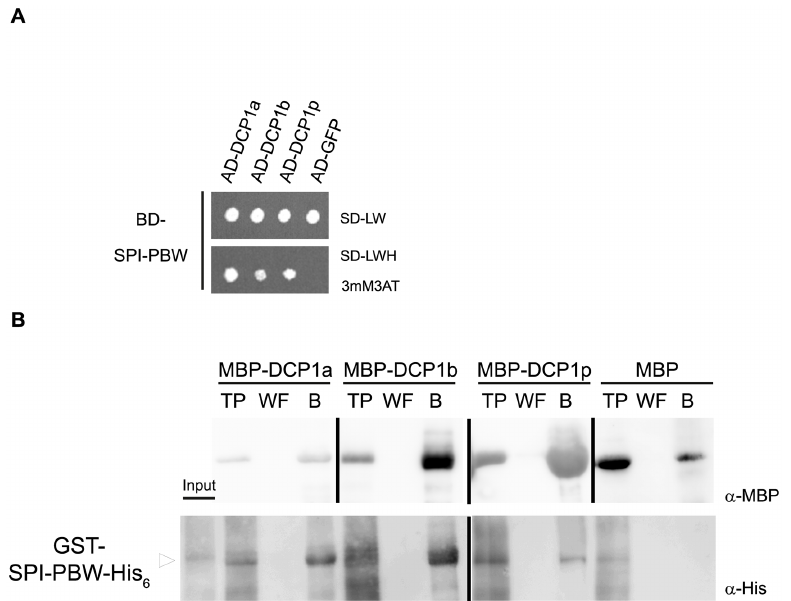
Fig 10. Interspecific interactions between SPI-PBW and DCP1 homologs from mammals and yeast. (A) Yeast two-hybrid interactions. Top part: double transformed yeast cells on selective dropout medium lacking leucine (-L) and tryptophan (-W). Bottom part: interactions between the SPI-PBW N-terminally fused to the GAL4 Binding Domain (BD) and the human DCP1 isoforms (DCP1a and b) and yeast DCP1p, N- terminal fused to the GAL4 Activation Domain (AD) on selective dropout medium lacking leucine (-L), tryptophan (-W) and histidine (-H), supplemented with 3 mM 3-Aminotrizole (3AT). GFP N-terminal fused to the GAL4-AD has been included as negative control. (B) Coprecipitations of bacterially expressed proteins. GST-SPI-PBW-His 6 (arrowhead, ~110 kDa) coprecipitated with MBP-DCP1a (~90 kDa), MBP-DCP1b (~92kDa) and MBP-DCP1p (~60 kDa), but not with MBP (~42 kDa) as negative control. Throughputs (TP), last wash fractions (WF), and resin bound fractions (B) are visualized by α -MBP (upper row) and α -His 6 antibody staining (lower row). Samples detected on different blots are separated by